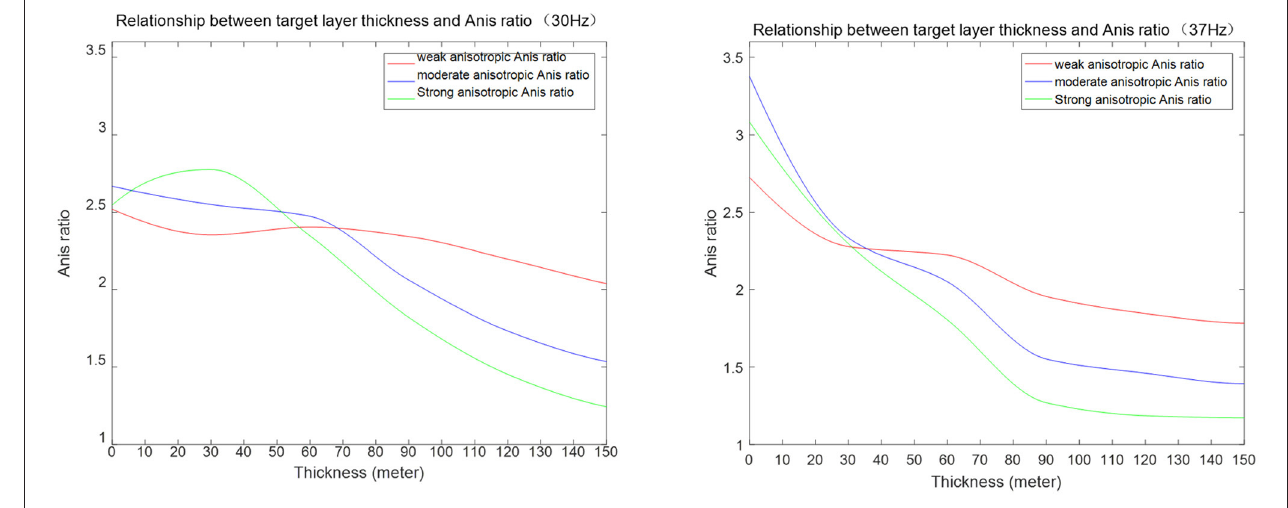
FIGURE 11 | Reflection coefficient of the qualitative model.